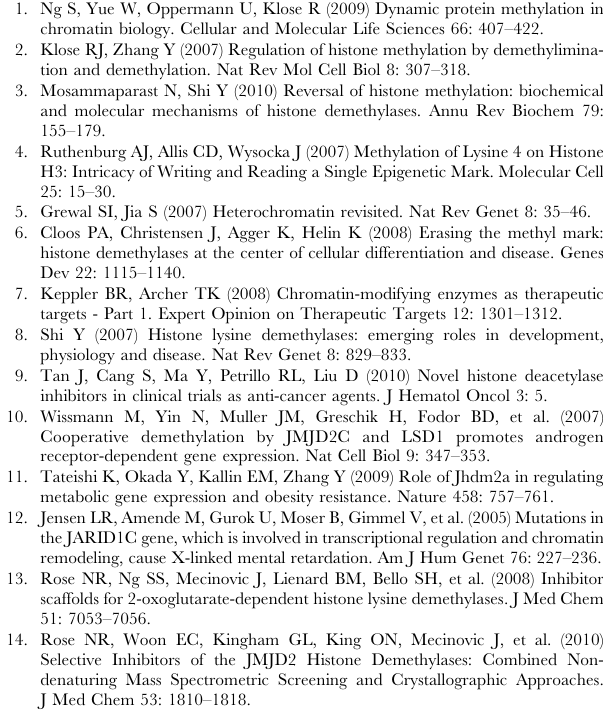
Figure S4 Inhibitor screening against JMJD2 and other human 2OG oxygenases. (A) Representative IC 50 curve for JMJD2A inhibition by SID 85736331. (B) Representative MALDI-TOF mass spectrum for JMJD2A demethylation reac- tions by MALDI-TOF MS at different inhibitor concentrations. (PDF) Table S1 Inhibitory activities of HTS Hits. Provided as a separate Excel spreadsheet. (XLSM) Table S2 Crystallographic data and refinement param- eters. Text S1 Synthetic and Analytical